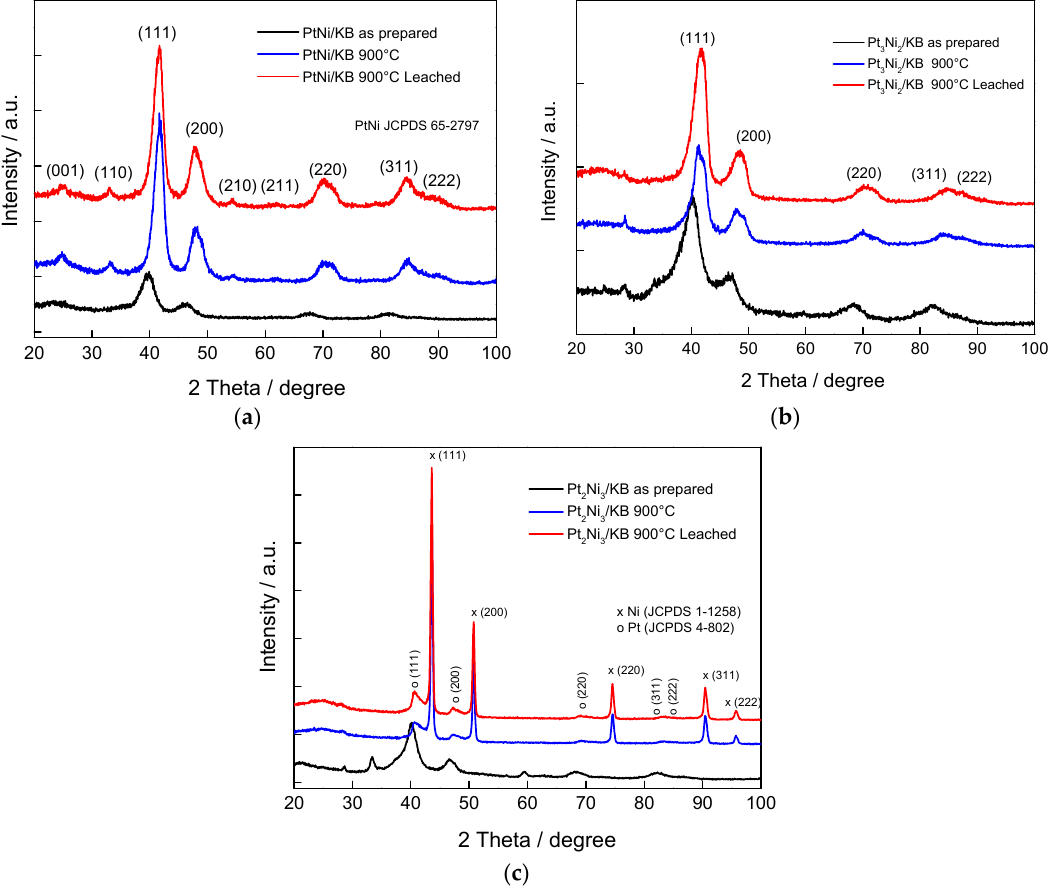
Figure 1. XRD patterns of carbon supported ( a ) Pt 1 Ni 1 ; ( b ) Pt 3 Ni 2 ; and ( c ) Pt 2 Ni 3 catalysts (as-prepared, treated at 900 °C and leached). Table 1. Physico-chemical properties of prepared catalysts.